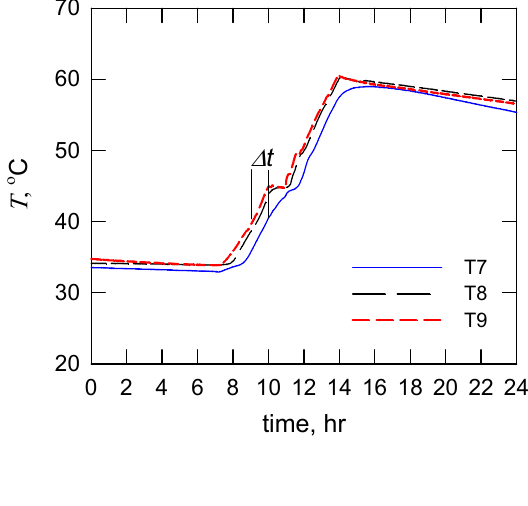
Figure 3. Temperature variation in the tank of S4, no-load